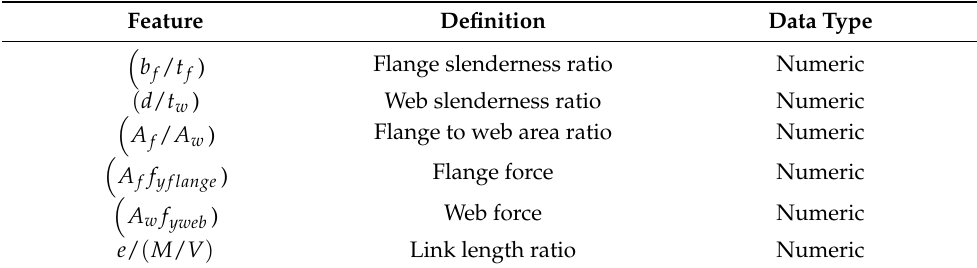
Table 1. Description of model